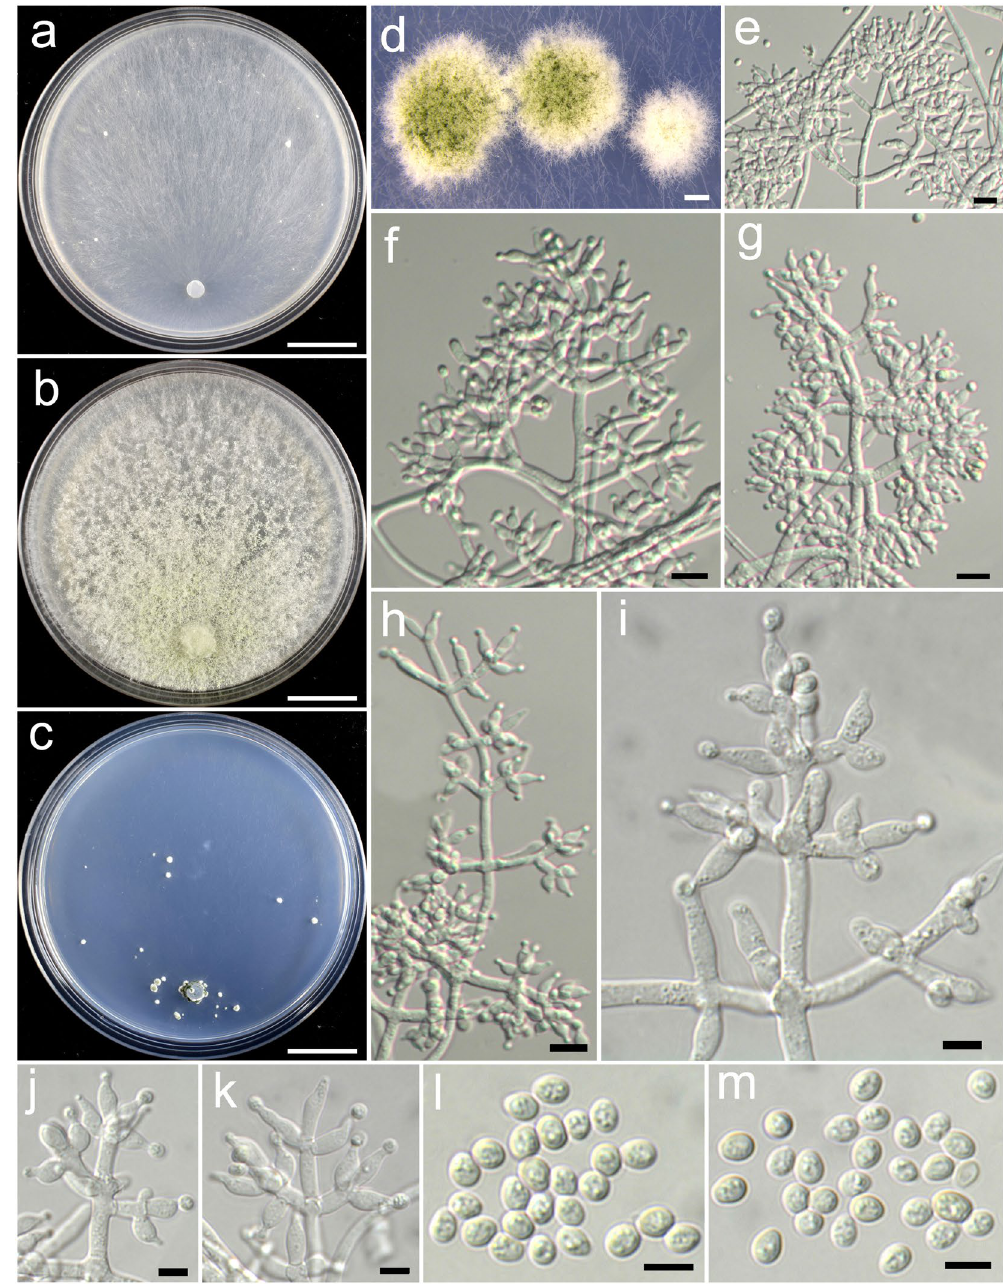
Figure 20. Trichoderma pseudodensum (HMAS 248828). ( a – c ) Cultures at 25 °C, 7 d (a. on CMD; b. on PDA; c. on SNA); ( d ) Conidial pustules (SNA, 7 d); ( e–k ) Conidiophores and phialides (PDA, 5 d); ( l , m ) Conidia (PDA, 5 d). Bars: a–c = 20 mm. d = 400 μ m. e–h = 10 μ m. i–m = 5 μ